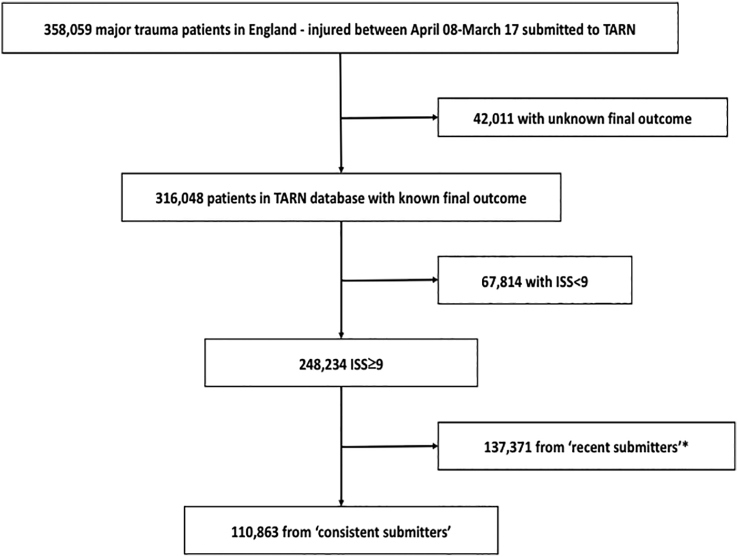
STROBE diagram identifying eligible study patients from TARN database in consistently submitting hospitals.*(Patients submitted from hospitals that began submitting after the study period commenced – these were combined with the study group in sensitivity analyses).